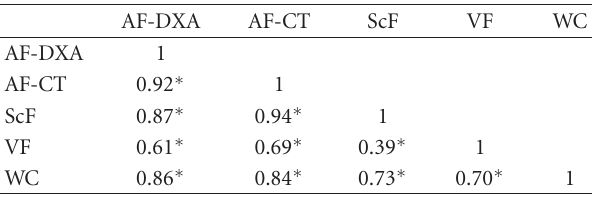
Table 2: Pearson’s correlations between AF-DXA, AF-CT, ScF, VF, and WC before weight loss interventions.